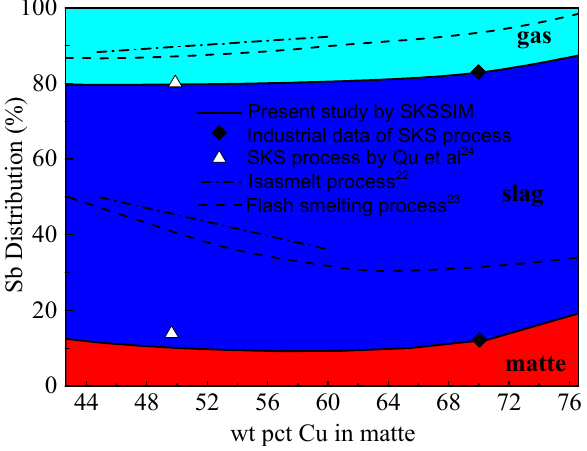
Figure 6. Antimony (Sb) distribution in the SKS smelting process.